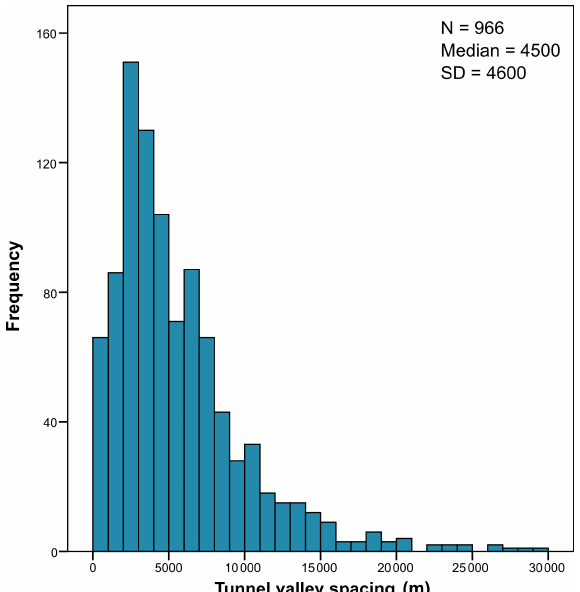
Figure 5. Frequency histogram of the spacing of 966 tunnel valleys from 24 discrete clusters across the southern sector of the former Laurentide Ice